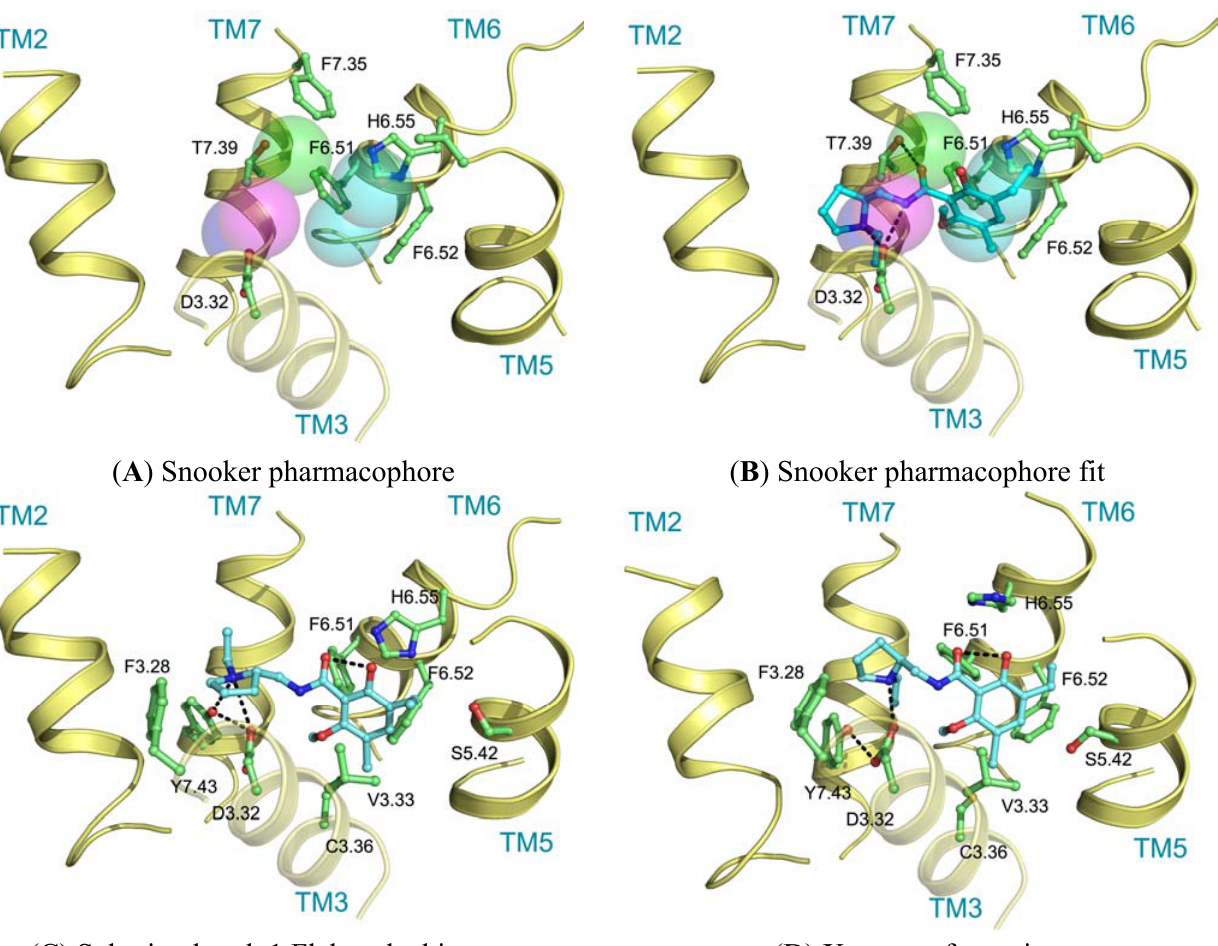
Figure 5. Binding pose as predicted by CDD-CMBI using Snooker and Fleksy compared to the X-ray